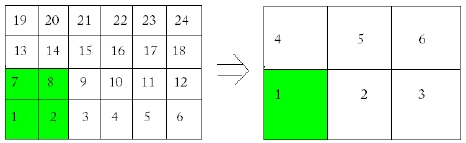
Figure 3. Standard coarsening means combining 2 × 2 cells into one coarse grid cell. For example, the shadow element 1 on the coarse grid (on the right) is obtained by combining four shadow elements 1,2,7,8 on the fine grid (on the left).